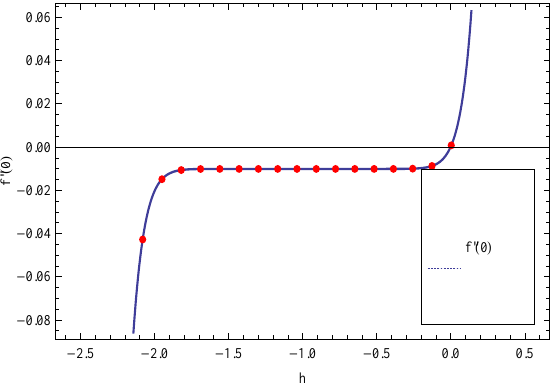
Figure 25. Illustrates the effect of β on φ ( η ) for h = − 0.25, λ = 0.5, S = 0.1,kr = 0.5,Ec = 0.5, Nb = 0.5,Nt = 0.6 and Sc = 0.6.